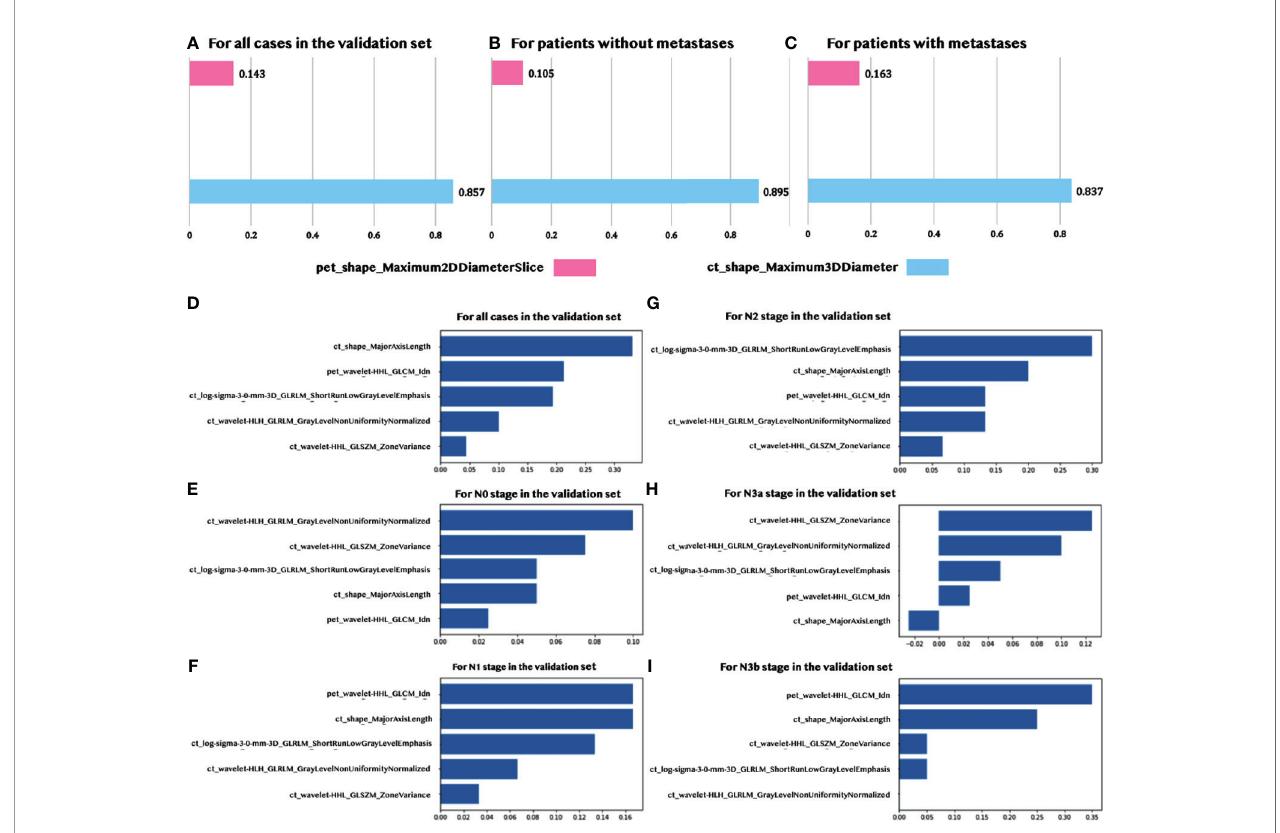
FIGURE 4 | Normalized feature importance. (A – C) Feature importance in predicting LNMs for all validation patients and patients with/without metastases. (D – I) Feature importance in predicting the N stage for all validation patients and patients with fi ve N stages (N0, N1, N2, N3a, and